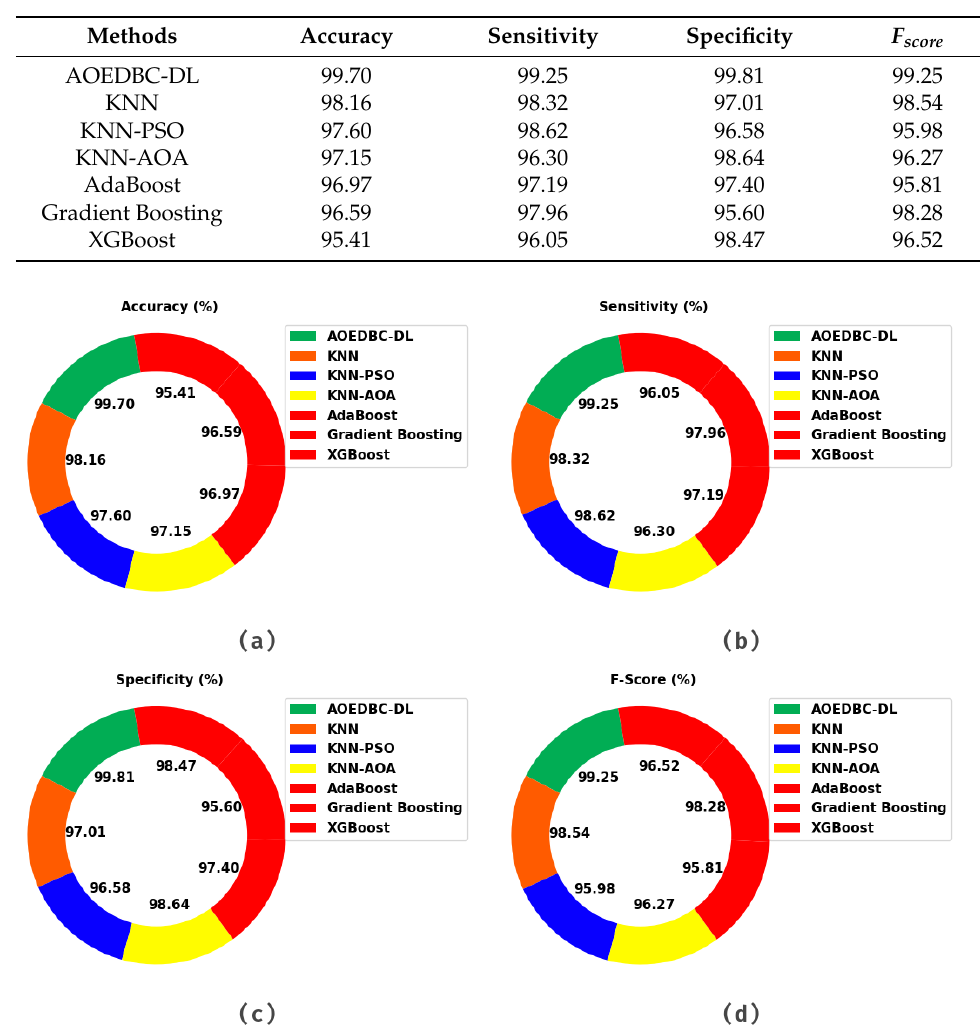
Table 3. Comparative analysis of AOEDBC-DL system with existing algorithms [28].